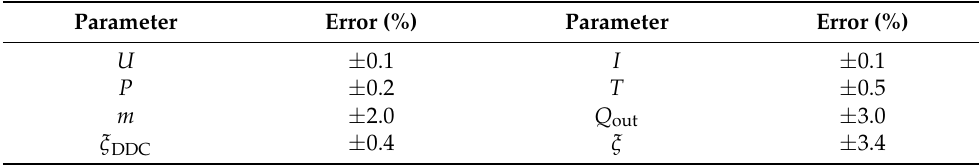
Table 3. Measuring errors and deduced parameter